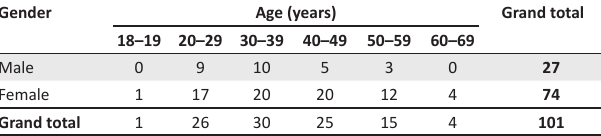
TABLE 1: Distribution of participants by age and